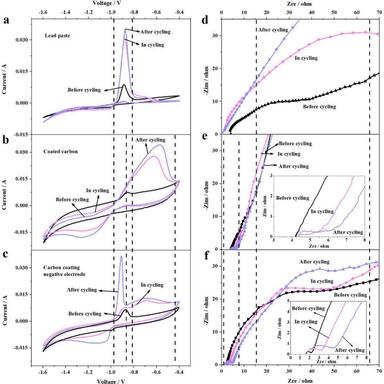
(a-c) and (d-f) The CV diagrams and Nyquist diagrams of the lead paste, the coated carbon and the carbon coating negative electrode during cycling. The scan rate of CV is 5 mV s − 1 . The voltage of the EIS is the open circuit voltage.